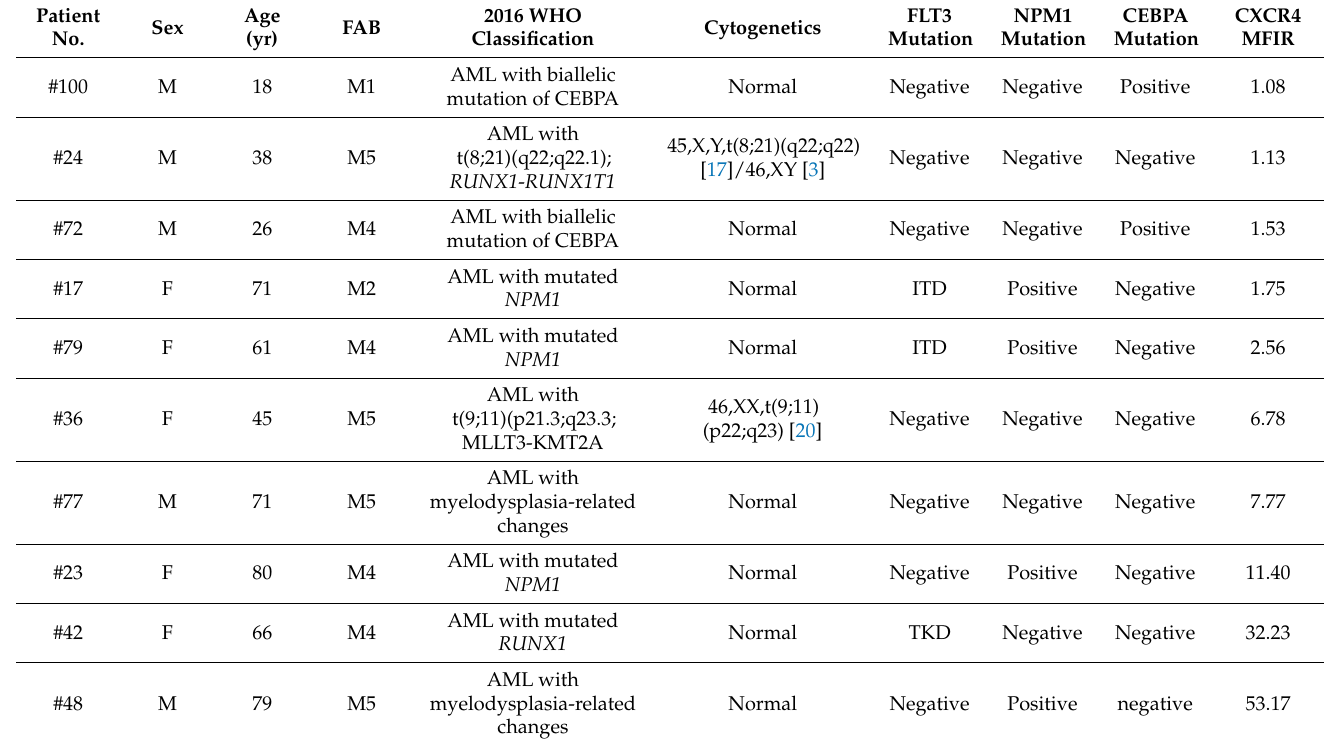
Table 1. Clinical and laboratory characteristics of 10 de novo AML